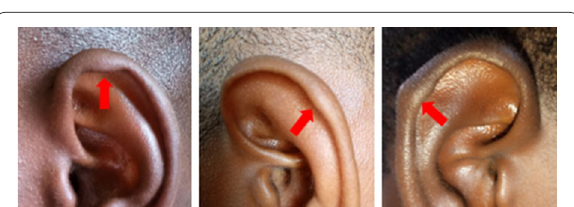
Fig. 5 Photographs of forms of earlobe attachment: free ( a ), partially attached ( b ), attached ( c )